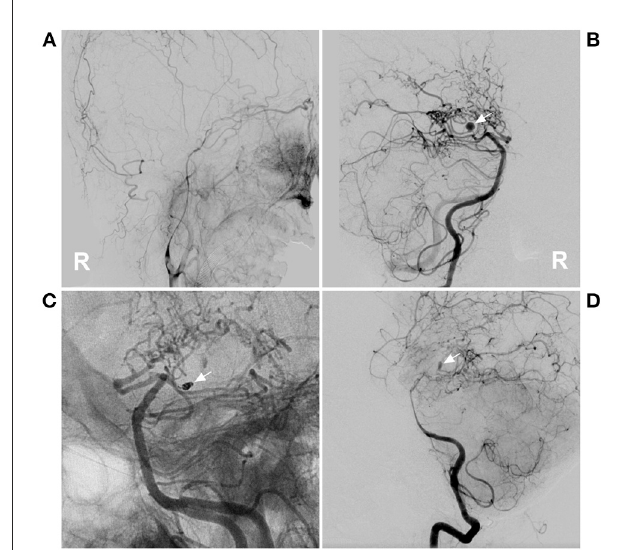
FIGURE1 PAO of the PCA aneurysm in MMD in case 4 in Table 1. (A) CT showed subarachnoid hemorrhage focusing on the right ambient cistern. (B) Three-dimensional DSA of the right ICA showed an aneurysm (arrow) at the P2–3 segment of the PCA. (C) Unsubtracted DSA of the right ICA showed that the aneurysm and proximal parent artery underwent PAO by coiling (arrow). (D) Follow-up DSA of the right ICA showed no recurrence of the aneurysm, and the collateral circulation beyond the coils was abundant (circle). CT, computed tomography; DSA, digital subtracted angiography; ICA, internal carotid artery; MMD, moyamoya disease; PAO, parent artery occlusion; PCA, posterior cerebral artery; R, right.